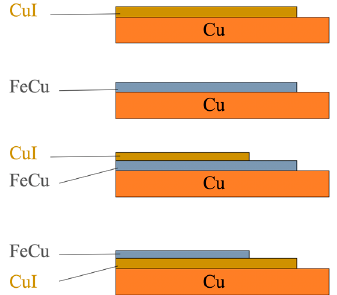
Figure 2. Deposition order of the FeCu and CuI materials on pure copper substrate (top to bottom: Cu/CuI, Cu/FeCu, Cu/FeCu/CuI and Cu/CuI/FeCu).